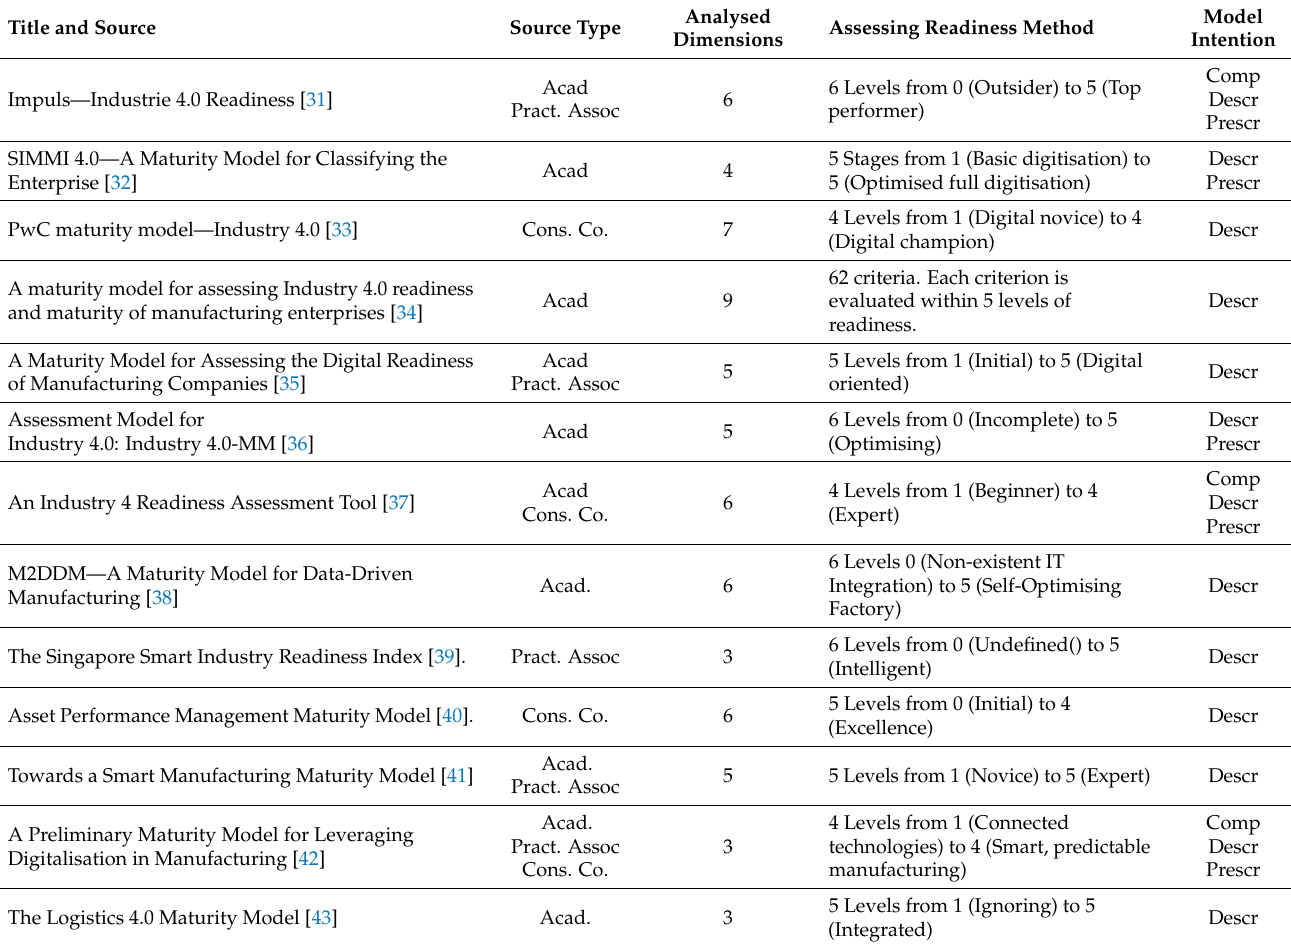
Table 1. The main attributes of maturity